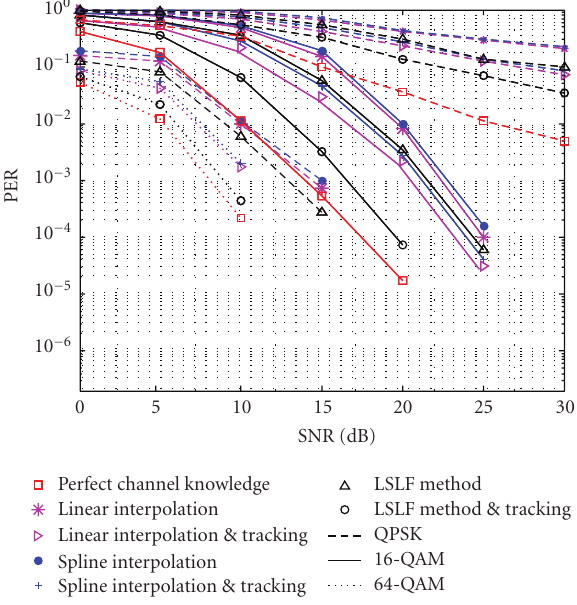
Figure 6: PERs in Ped.B 6km/h.